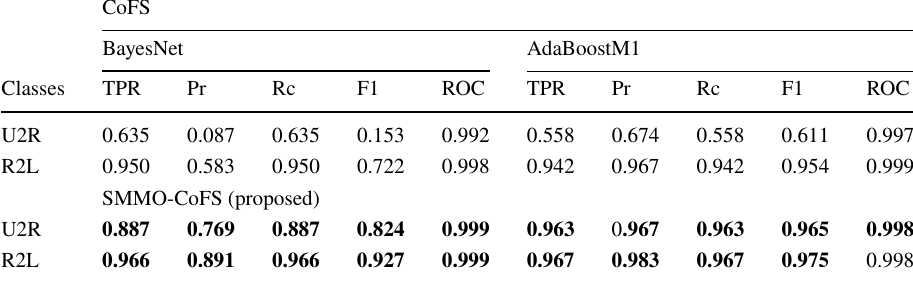
Bold values indicate the best results obtained